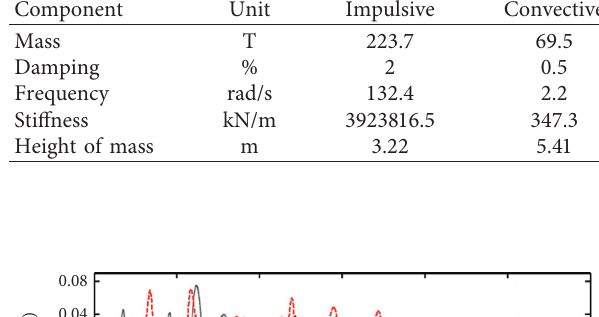
Table 2: Dynamic properties of steel water storage tank. Component Unit